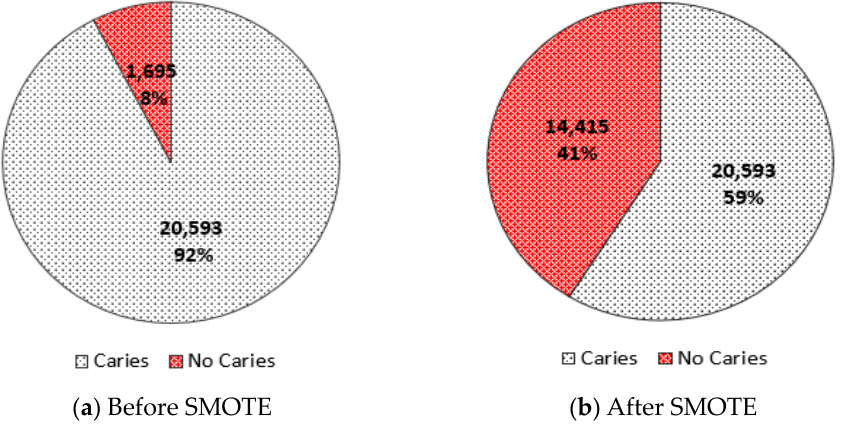
Figure 2. Data distribution ratio with respect to the target variable: ( a ) before SMOTE; ( b ) after SMOTE.